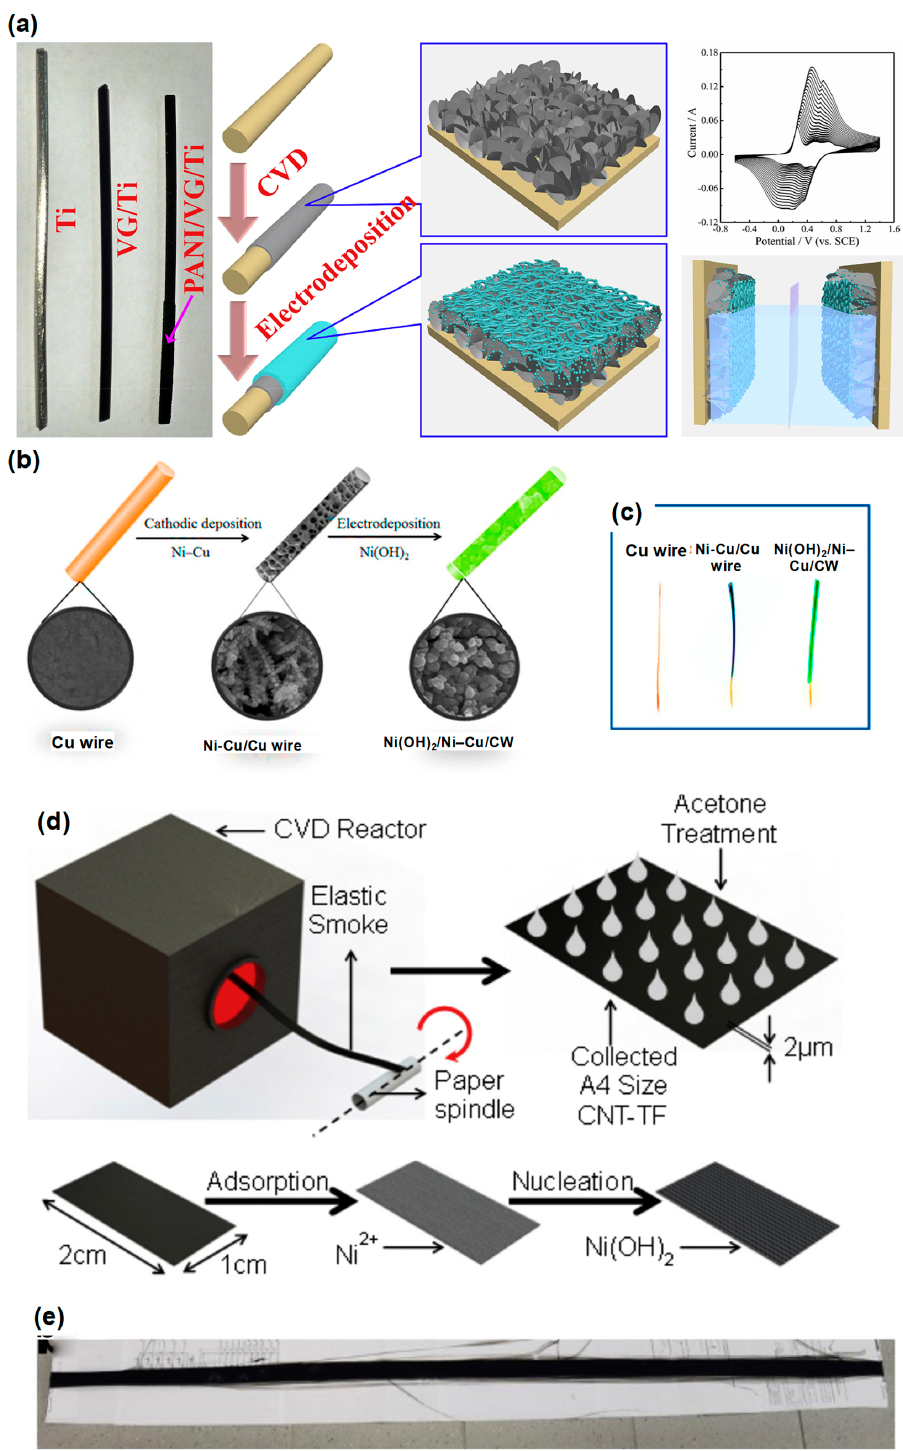
Figure 4. ( a ) Schematics of the synthesis procedure for the PANI/Gr/Ti wire electrode and symmetrical supercapacitor. Reproduced with permission from ref. [40]. Copyright 2018 Elsevier. ( b ) Schematic illustration of the preparation of Ni(OH) 2 /Ni–Cu/CW. ( c ) Typical digital images of the Cu-wire, Ni–Cu/CW and Ni(OH) 2 /Ni–Cu/CW. Reproduced with permission from ref. [41]. Copyright 2018 American Chemical Society. ( d ) Schematic illustration of the continuous fabrication of CNT films and the synthesis of the Ni(OH) 2 /CNTs composite and ( e ) digital photo of the obtained CNT films with length ~1.5 m. Reproduced with permission from ref. [2]. Copyright 2015